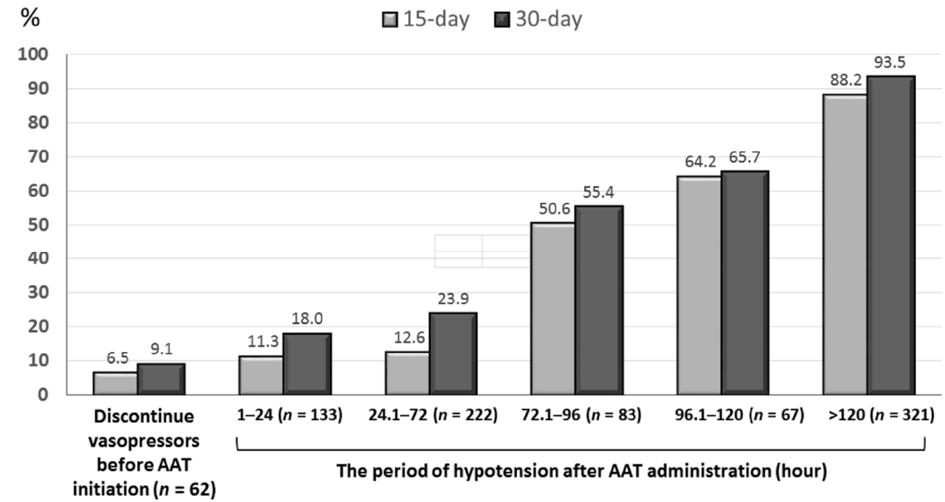
Figure 3. A positive trend of the hypotension period after AAT initiation in the 15-day ( γ = 0.957, p = 0.003) and 30-day ( γ = 0.975, p = 0.001) crude mortality rate, tested by the Pearson’s correlation. AAT = appropriate antimicrobial therapy.